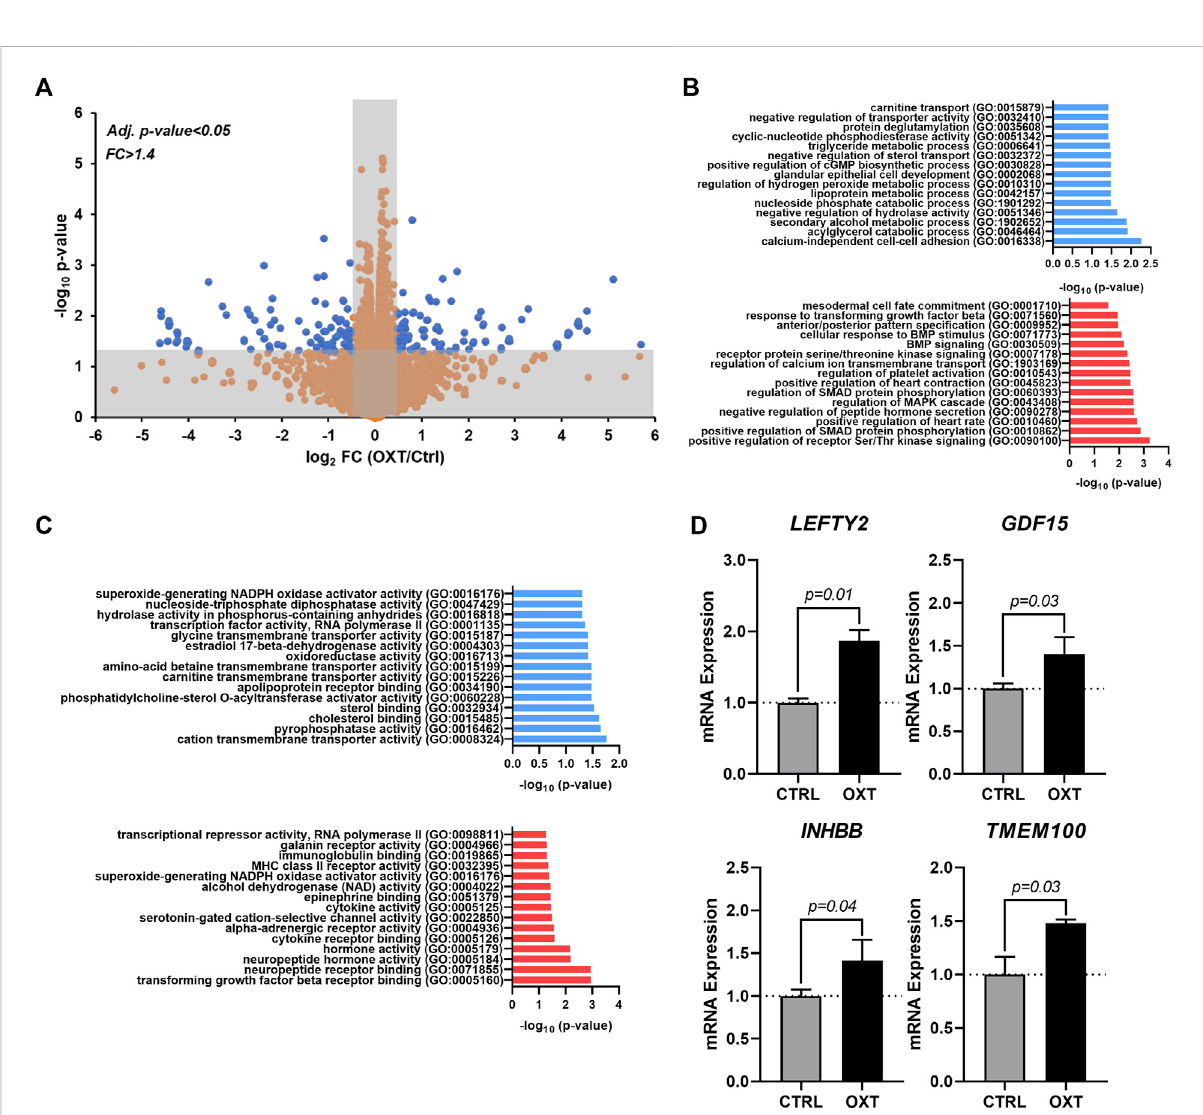
FIGURE 4 Transcriptome Analysis of Oxytocin-Treated Human Epicardial Cells. (A) Volcano plot showing differentially expressed genes between control andOXT-treatedhEpiCs,asdeterminedbyRNAsequencing;Bluedotscorrespondtogeneswithafoldchange ≥ 1.4anda p -value ≤ 0.05. (B,C) Gene ontology analysis showing upregulated and downregulated biological processes (B) and molecular functions (C) after oxytocin exposure in hEpiCs. (D) Relative mRNA expression of ligands for the TGF- β pathway and activators of BMP signaling in control and OXT-treated hEpiCs; n = 3 per